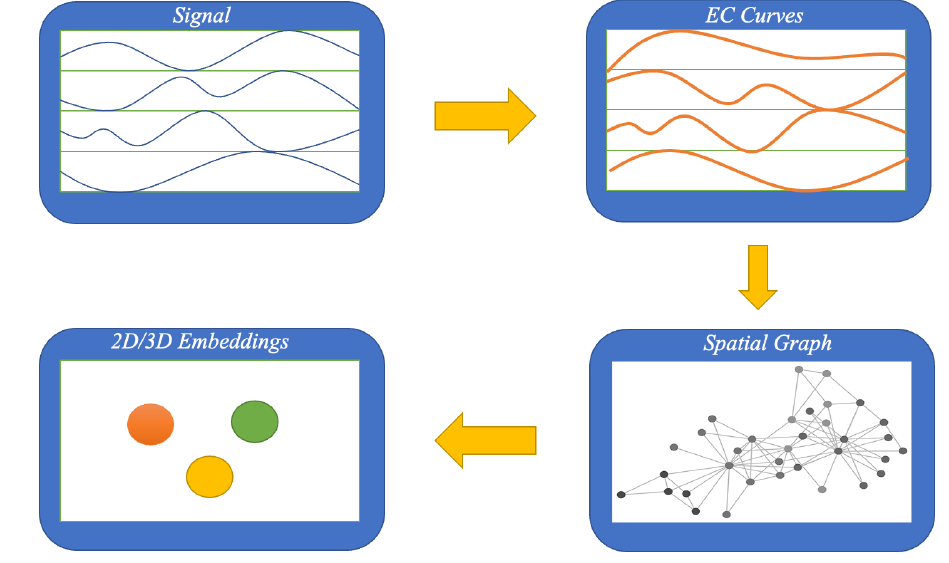
Figure 1. A flowchart of the proposed